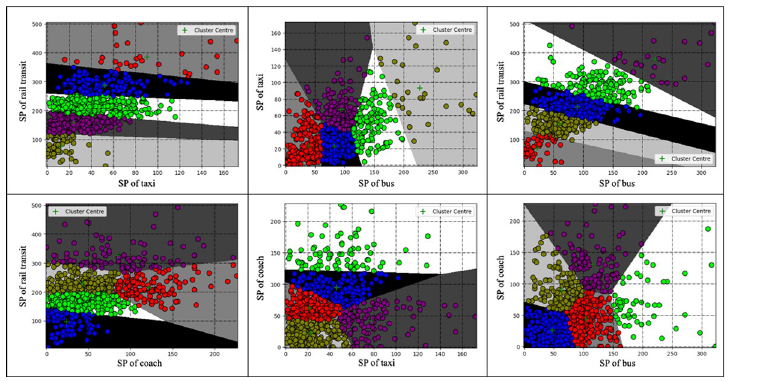
Fig 6. SP cluster analysis results.